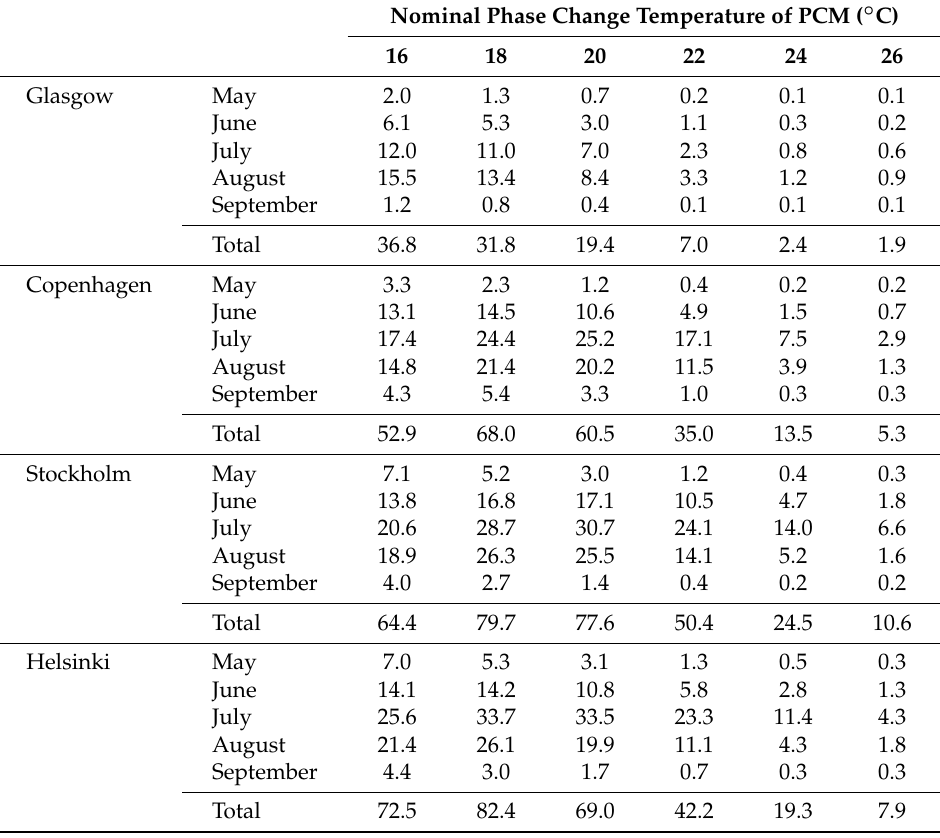
Table 2. Energy saving potential in kWh (cities above 55 ◦